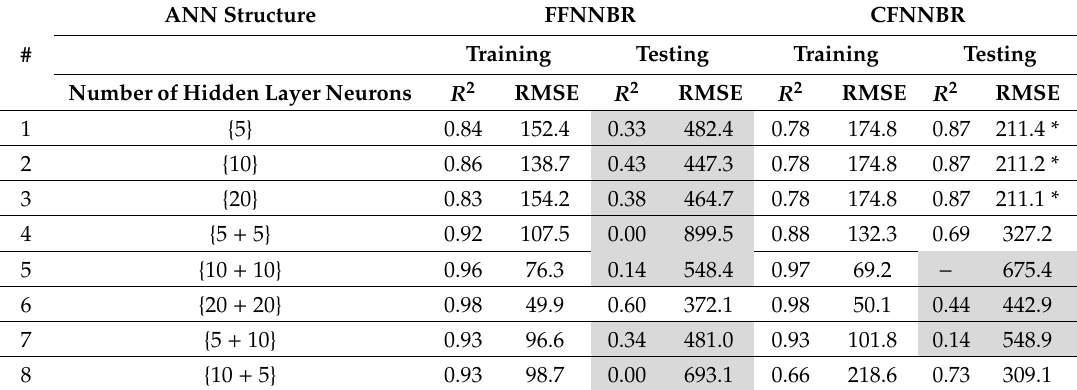
Table 5. Results on ANN trained with 4 features ( x 1 , x 2 , x 4 , x 5 ) using the Bayesian Regularization (BR)